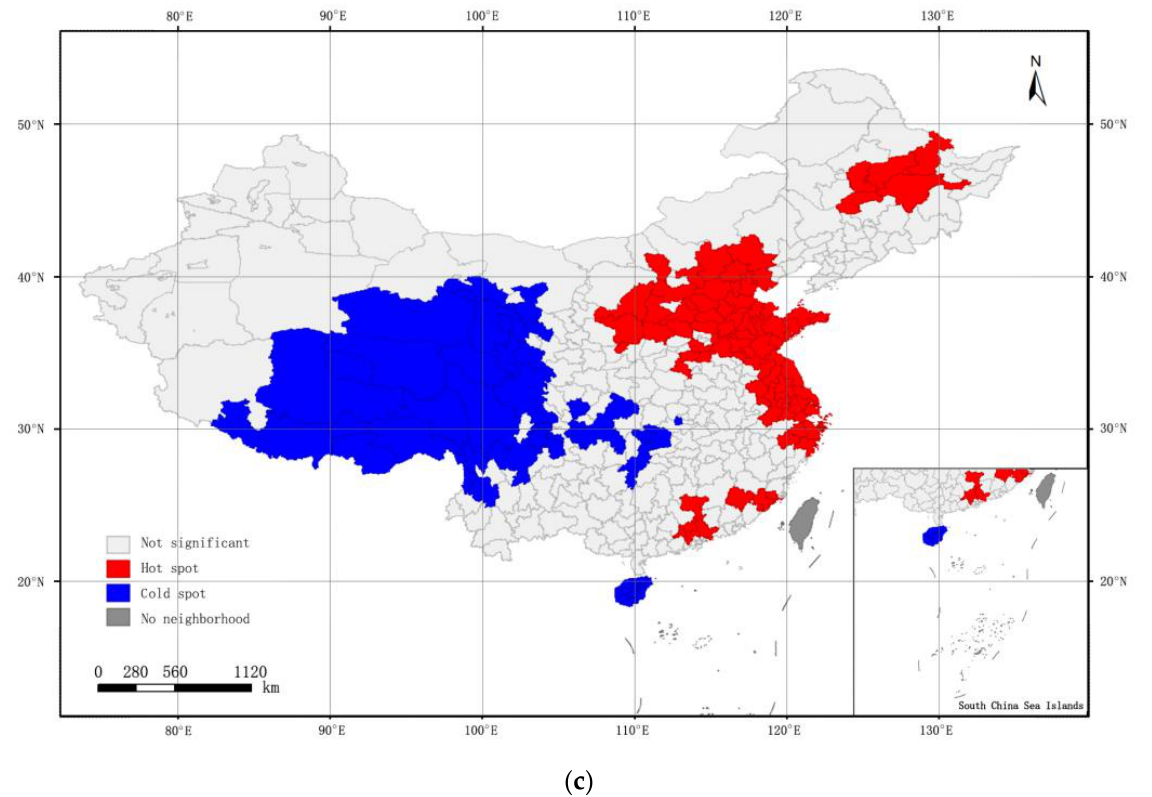
Figure 5. Local spatial autocorrelation and cold – hot spot analysis of the municipal ODR. ( a ) LISA cluster map; ( b ) LISA significance map; ( c ) Gi* cluster map.